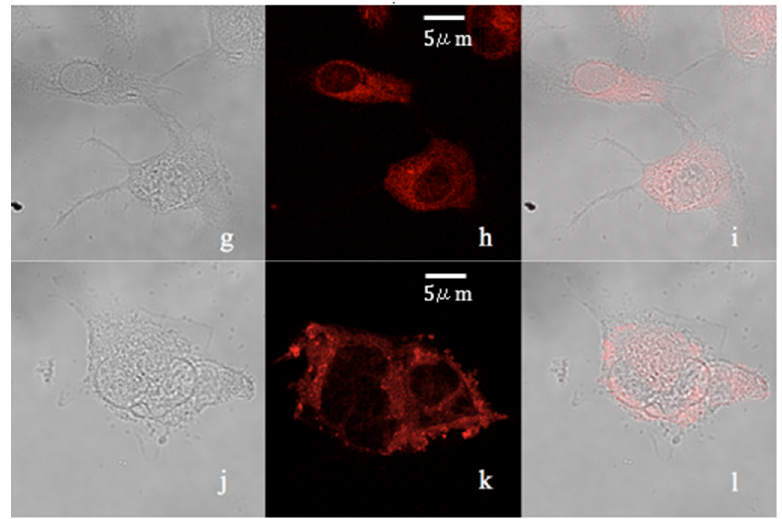
Figure 6. Visualization of the cytoplasm of SVG (non-tumoral) ( g – i ) and U-251 (tumoral) ( j – l ) cell lines with Compound 5 using confocal microscopy. Images are labeled as follows: ( g , j ) bright field; ( h , k ) fluorescence; and ( i , l ) merged images. Laser used 560 nm (red).